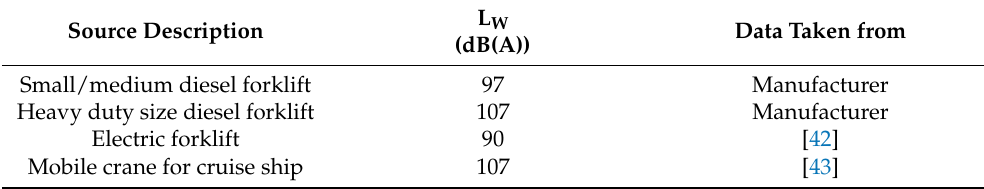
Table 9. Sound power level of forklifts, as reported in [20].